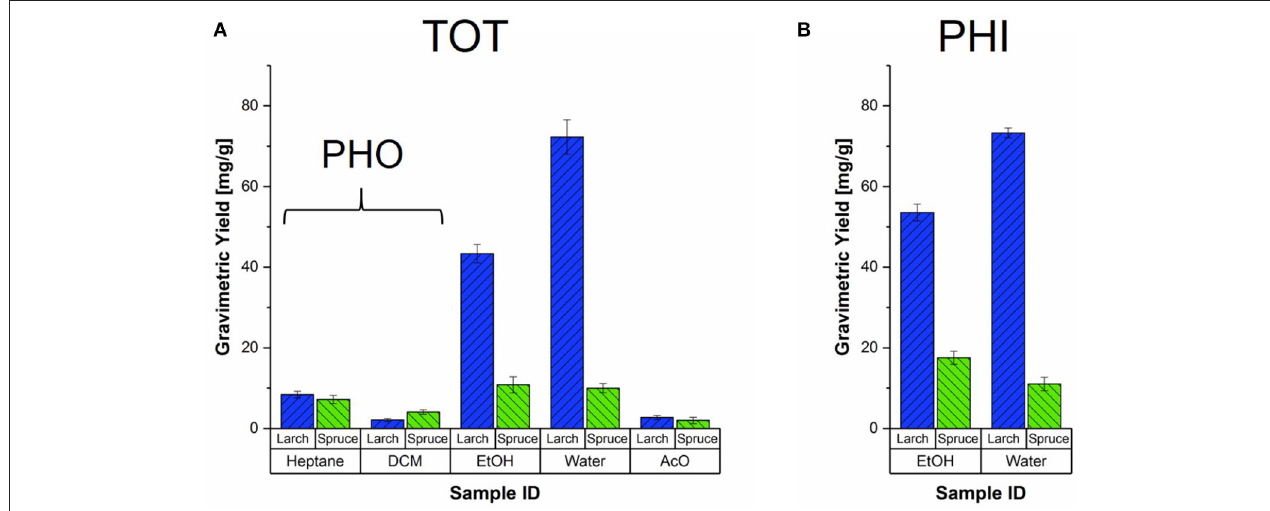
FIGURE 3 | Gravimetric yields of all the solvent fractions and extraction strategies for milled Norway spruce and Kurile larch. (A) Average yields of the milled, total extracted samples (TOT) obtained from two clones of Picea abies (green) and Larix gmelinii var. japonica (blue), with respective standard deviations. The TOT heptane and DCM yields should be considered as reference for the hydrophobic extracted samples (PHO). (B) Average yields per species obtained from the extraction with hydrophilic solvents, Ethanol (EtOH) and